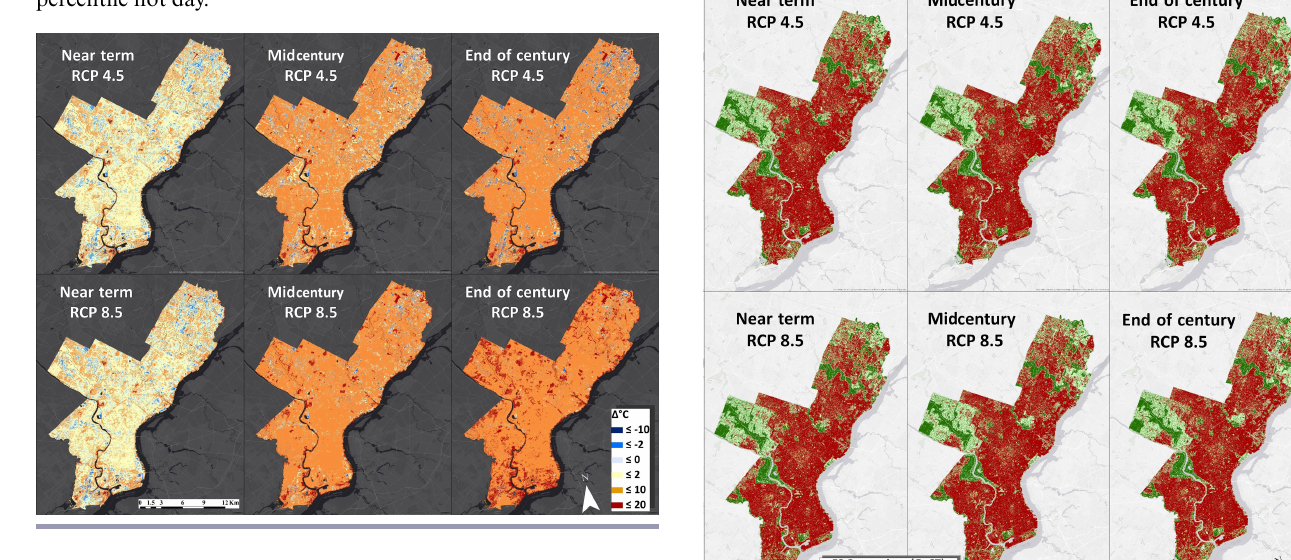
Fig. 3 . Predicted change in surface temperatures over time, under climate change scenarios RCP4.5 and RCP8.5 on a 95th percentile hot day.